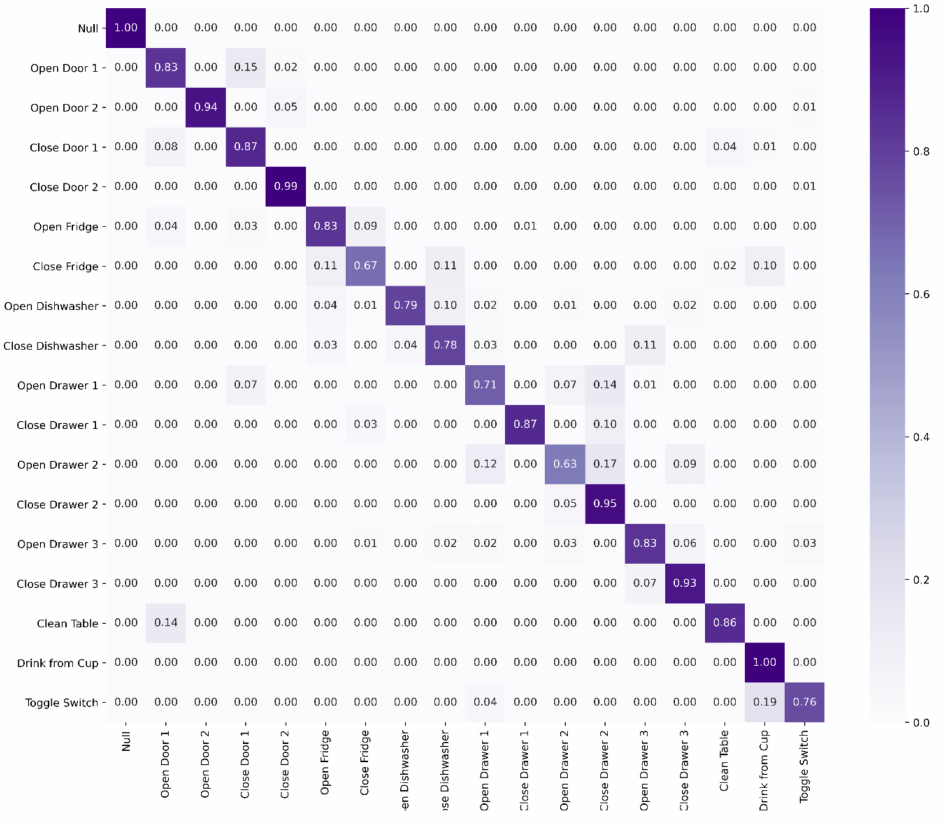
Figure 14. Confusion matrix of the model on the testing dataset for upper body recognition